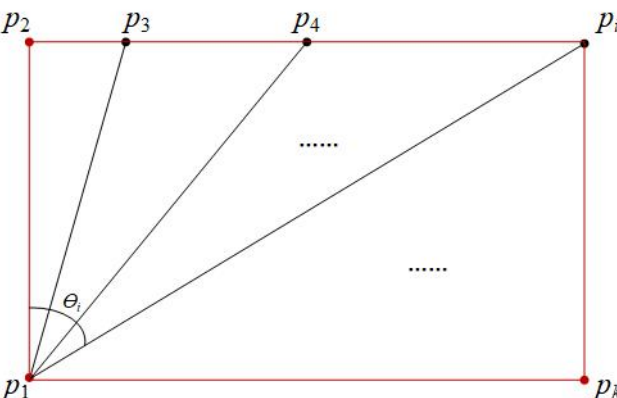
Figure 6. An example of Corollary 1, two adjacent boundary lines have the largest turning